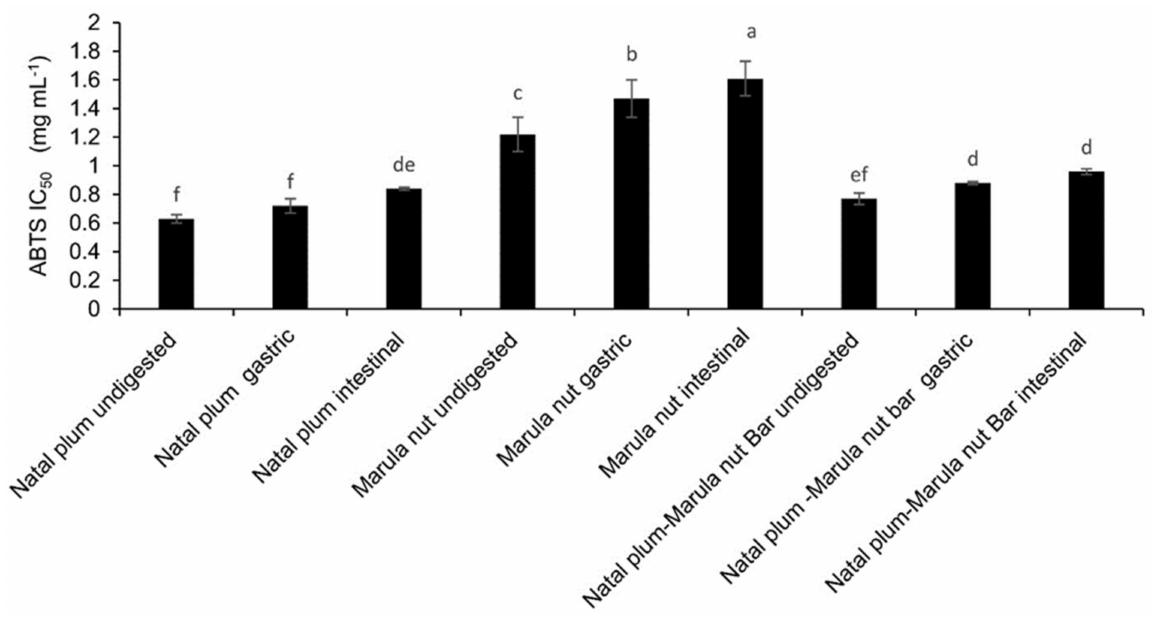
Figure 4. Effect of co-ingestion of Natal plum and Marula nut in a bar on the antioxidant capacity Means followed by the same letter in a bar are not significantly different at p < 0.05.